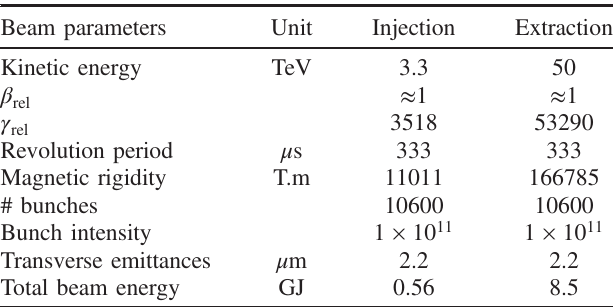
TABLE I. Beam parameters for FCC injection and